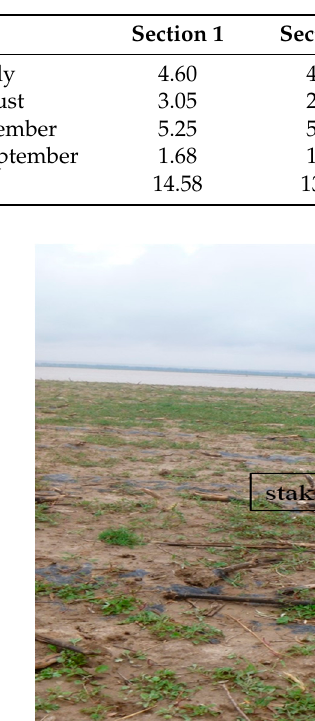
Table 2. Collapse distances (m) recorded in 2011.